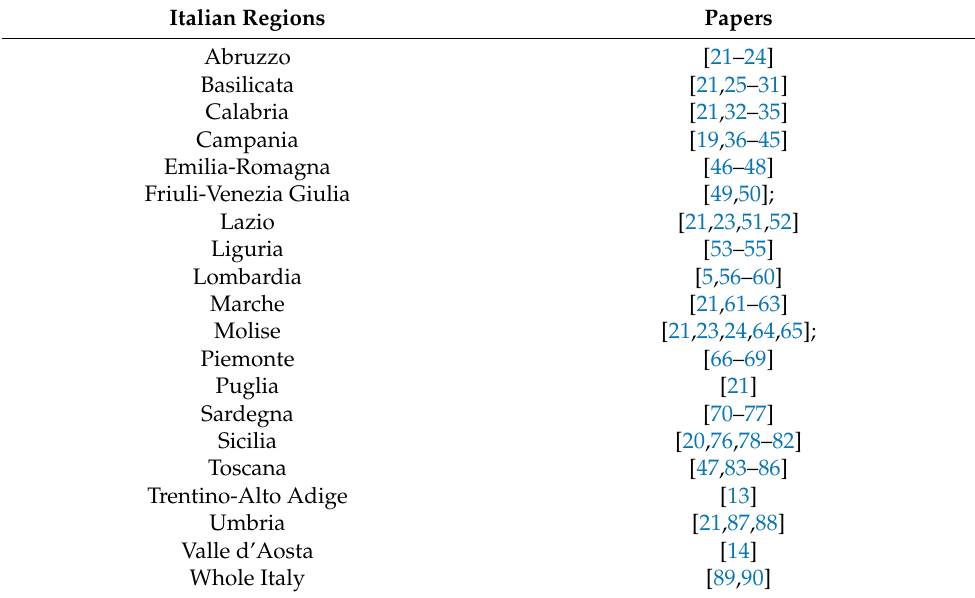
Table 1. Reviewed papers according to the distribution in Italian regions. Italian Regions